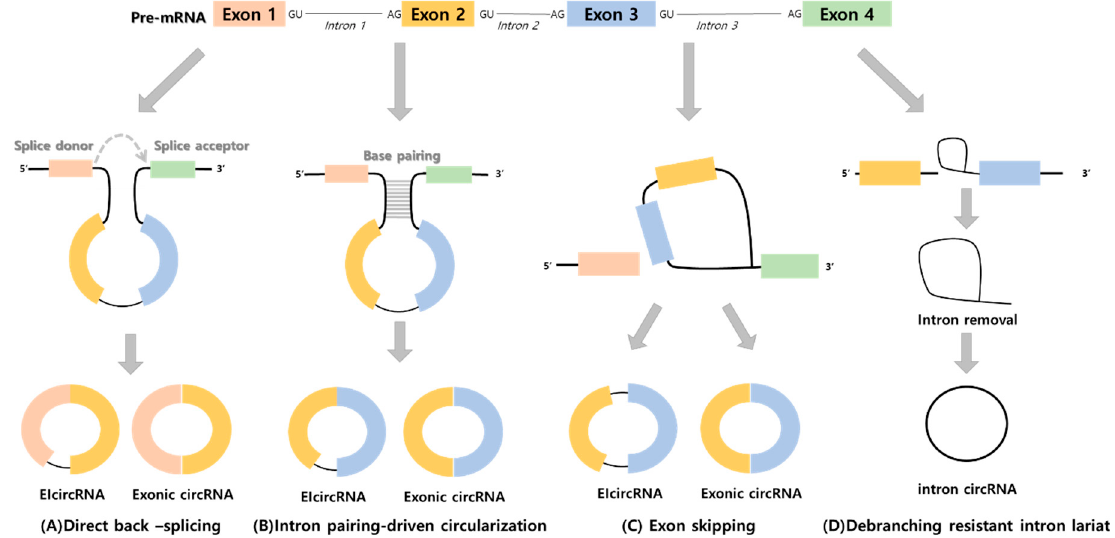
Figure 1. Biosynthetic mechanisms of circular RNAs. Circular RNAs are produced via several induction mechanisms: ( A ) direct back-splicing, ( B ) intron-pairing-driven circularization, ( C ) exon skipping, and ( D ) debranching-resistant intron lariat. EIcircRNA; Exon-intron circRNA.